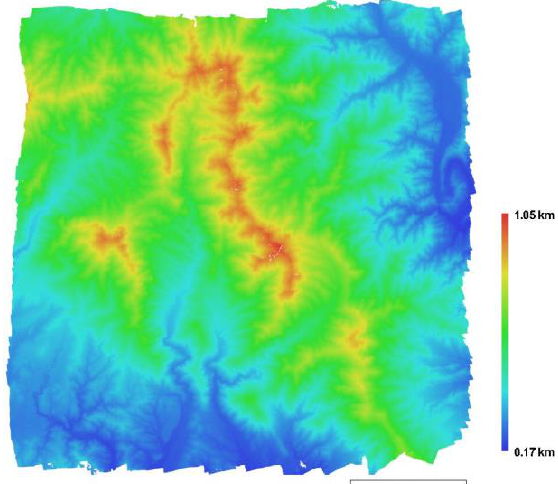
Figure 8. The 0.3m DEM produced by UAV photogrammetry To evaluate the vertical accuracy of the ASTER GDEM2 data, the DEM produced by UAV photogrammetry is down-sampled to 30m by nearest neighbor interpolation. The elevation values at the edges of the DEM are not reliable due to few image observations (Figure 6). Therefore, the UAV DEM is masked to clip the edges. After the masking process, pixel-wise errors are derived by subtracting the UAV DEM from the ASTER DEM. Figure 9 shows the spatial distribution of the errors.